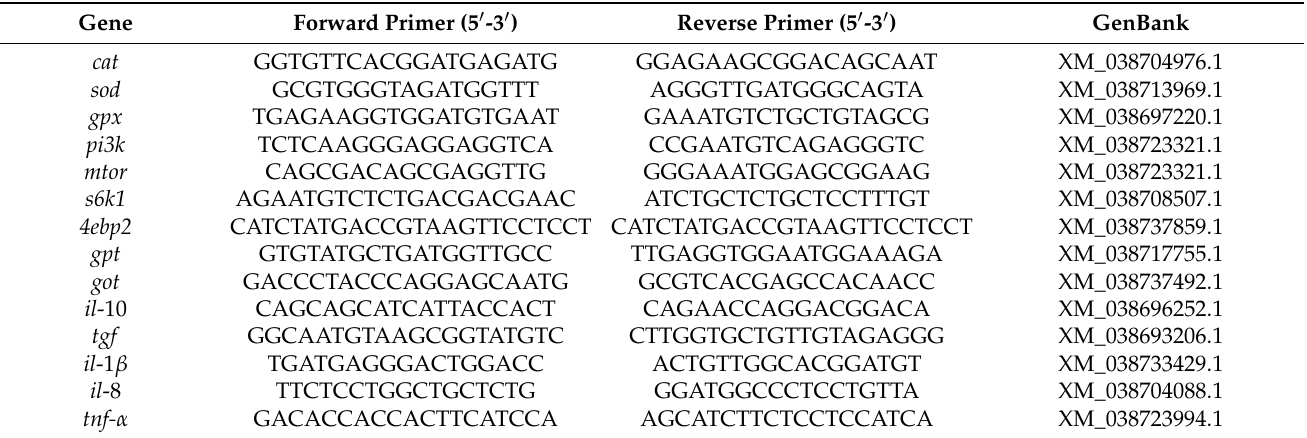
Table 3. Primer pair sequences for real-time PCR.